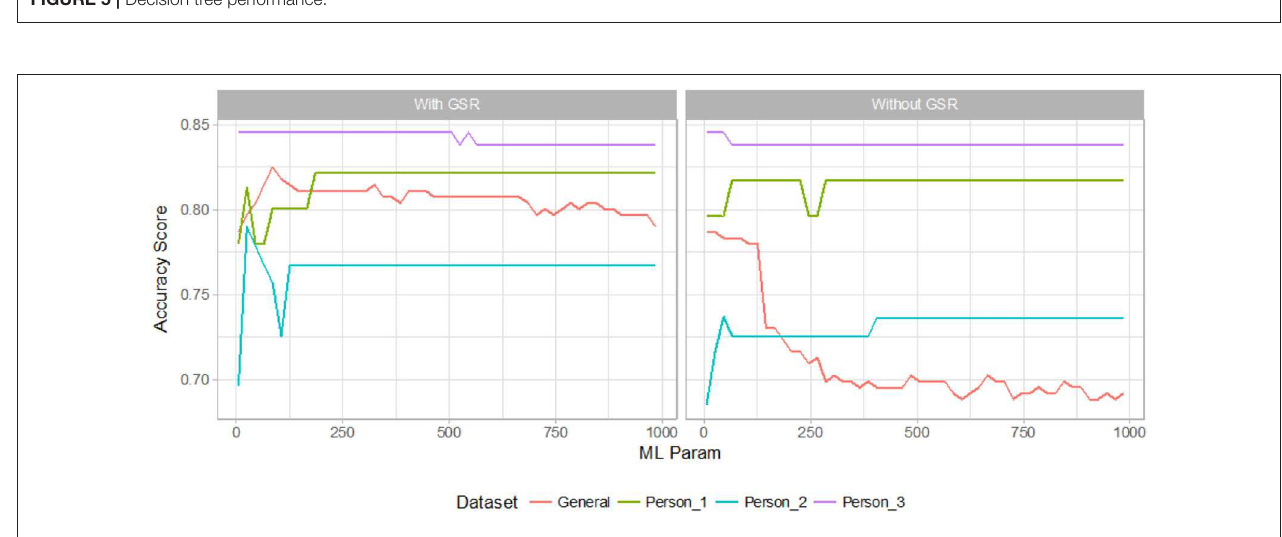
FIGURE 6 | AdaBoost classifier performance.